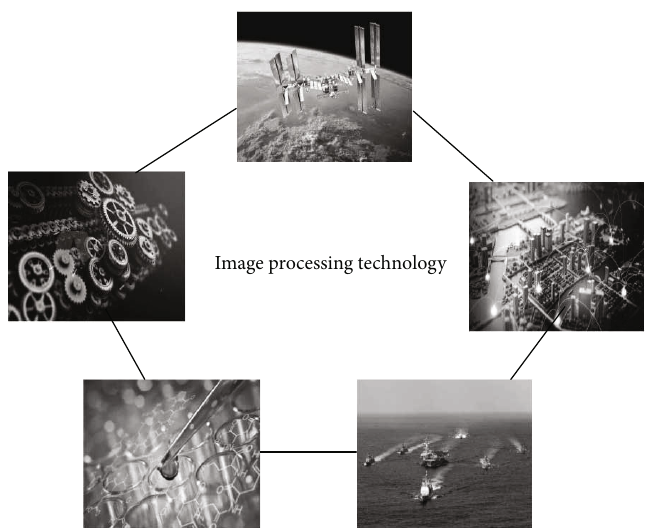
Figure 2: Application areas of image processing